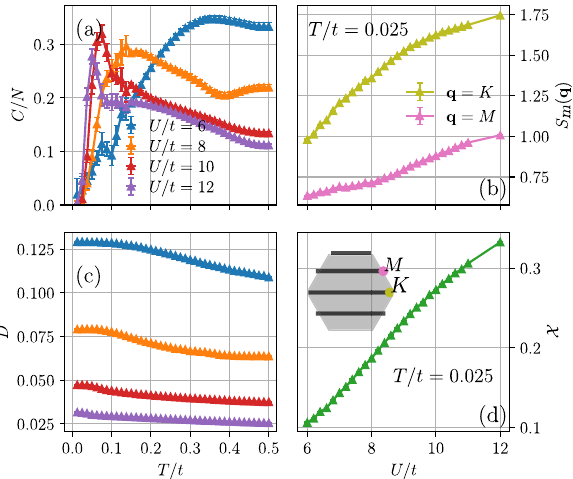
FIG. 12. Key results on the XC4 cylinder from METTS.